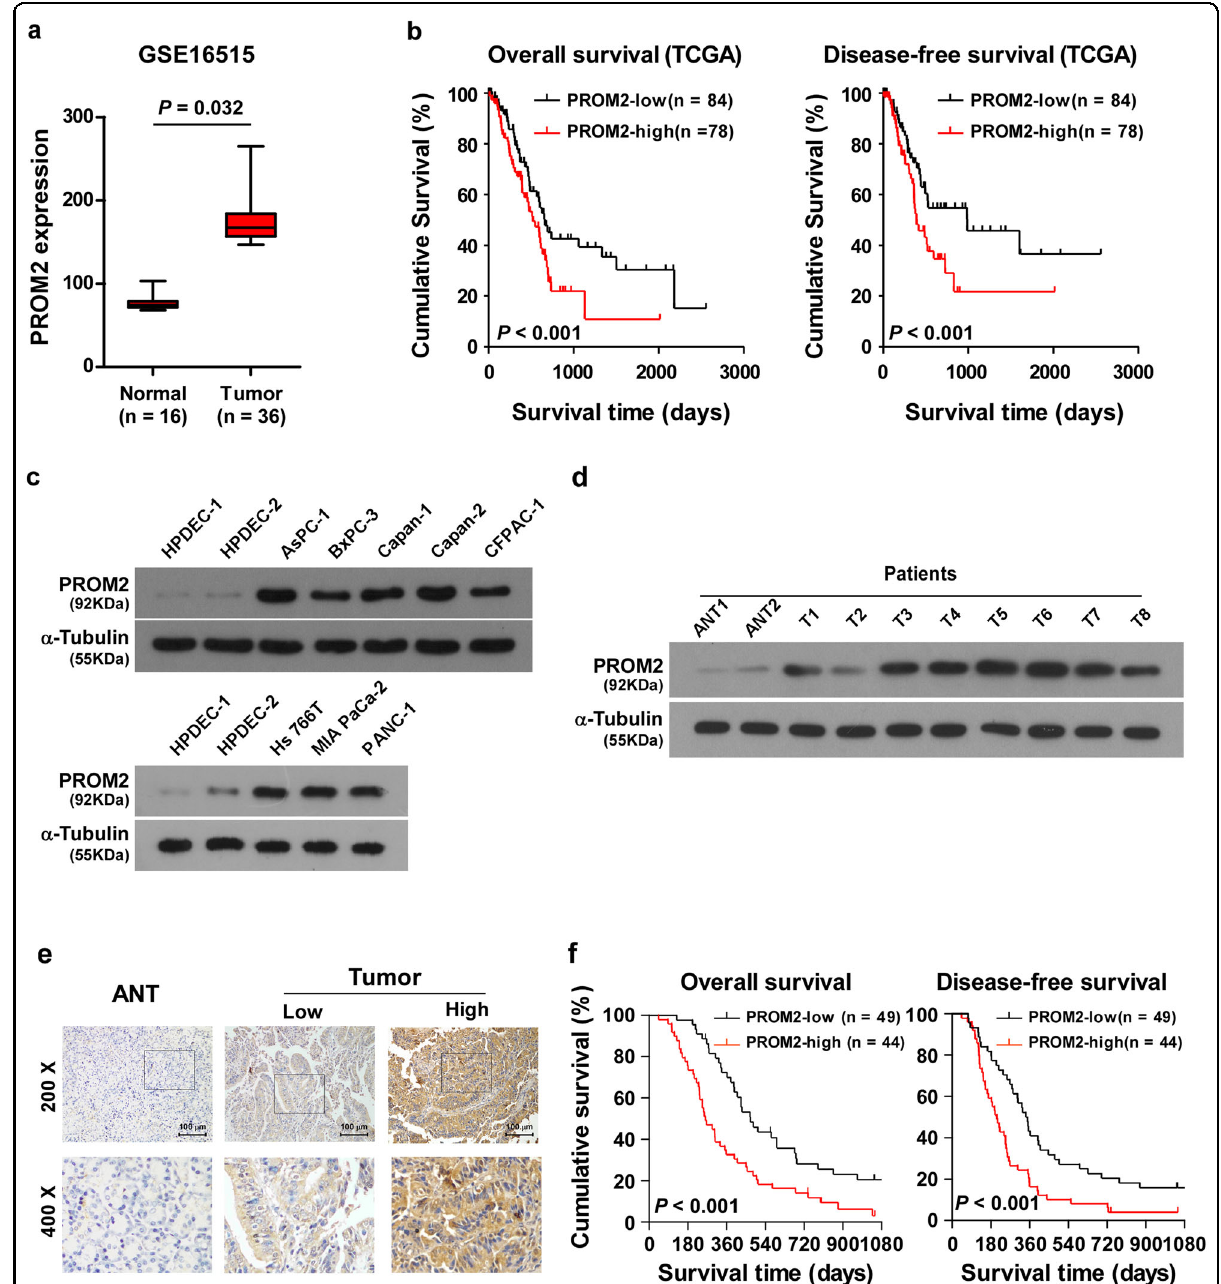
Fig. 1 Overexpression of PROM2 is positively correlated with pancreatic cancer progression. a PROM2 is overexpressed in pancreatic tumor tissues versus normal tissues (NCBI/GEO/GSE16515, P = 0.032). b High expression of PROM2 is correlated with poor overall survival and disease-free survival in pancreatic cancer ( P < 0.001, P < 0.001; TCGA, n = 162). c PROM2 protein expression is upregulated in all eight pancreatic cancer cell lines compared with immortal pancreatic ductal epithelial cell (HPDECs). d PROM2 protein is overexpressed in eight pancreatic cancer tissues (T1 – T8) versus adjacent tissues of pancreatic cancer (N1, N2). e Representative images of adjacent tissues and tumor tissues stained with the PROM2 antibody by IHC assay. f Correlation between PROM2 expression and overall/disease-free survival ( P < 0.001, P < 0.001; n =